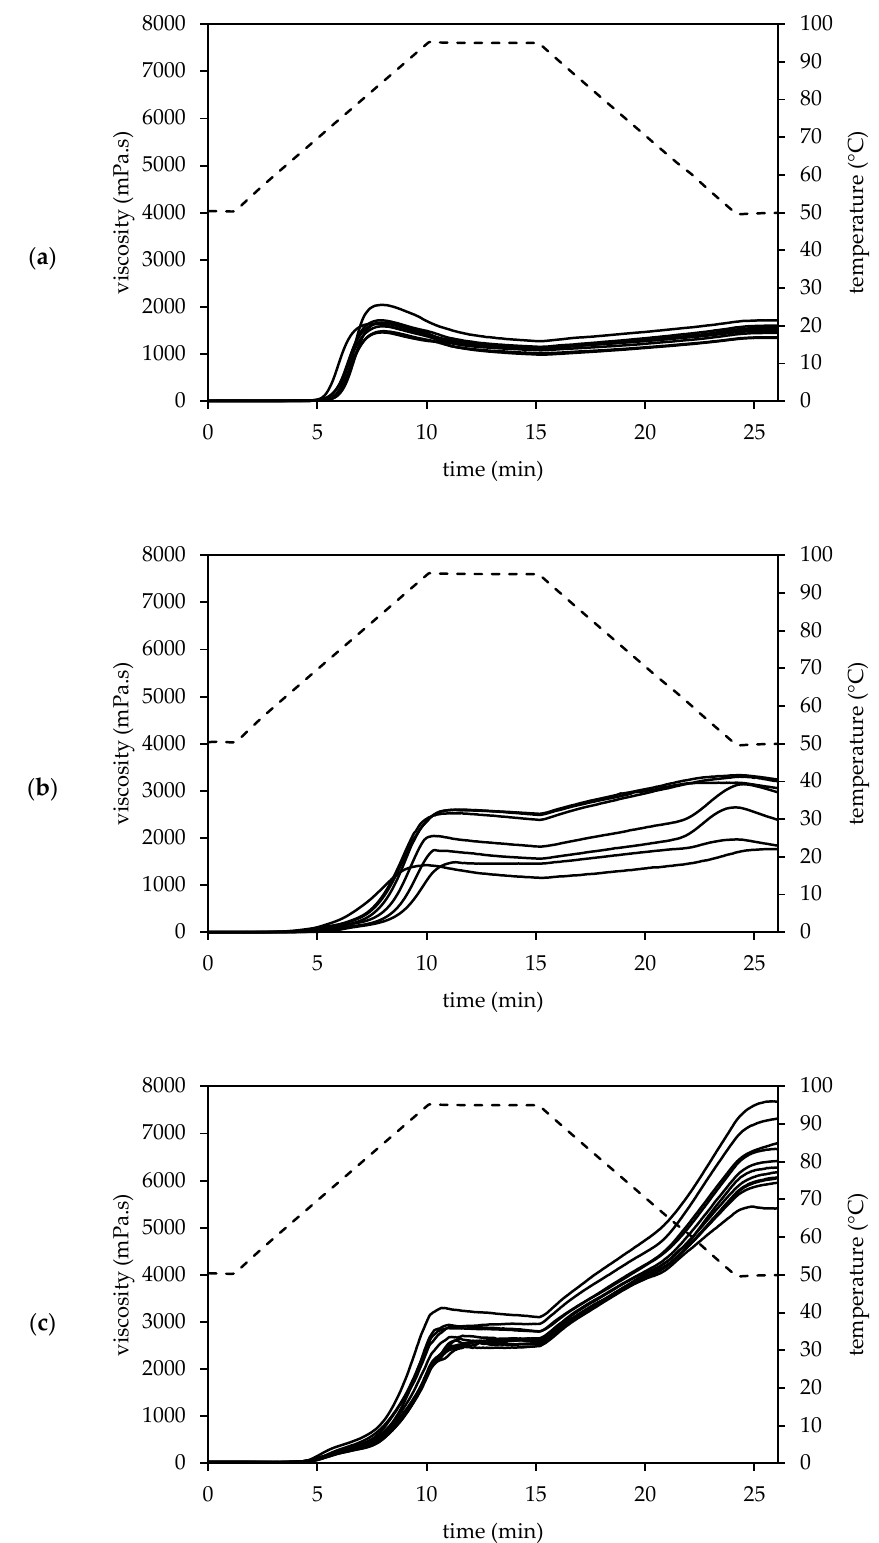
Figure 2. Pasting behaviour of amaranth ( a , n = 8), quinoa ( b , n = 7) and buckwheat ( c , n = 10) wholemeal flour.